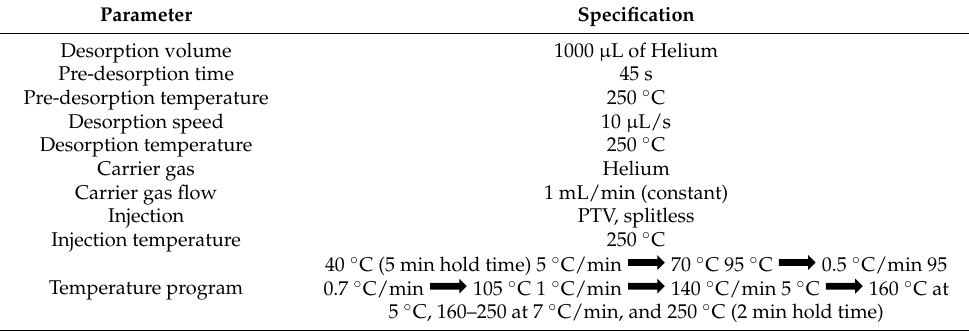
Table 2. GC parameters for analyses of infusions (by HS-SPDE).